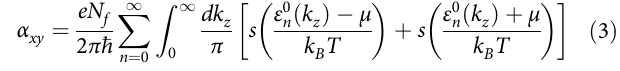
in which s is the electronic entropy function (Eq. S13). The mag- is comparable to the simple weighted average of projected nitude v eff F